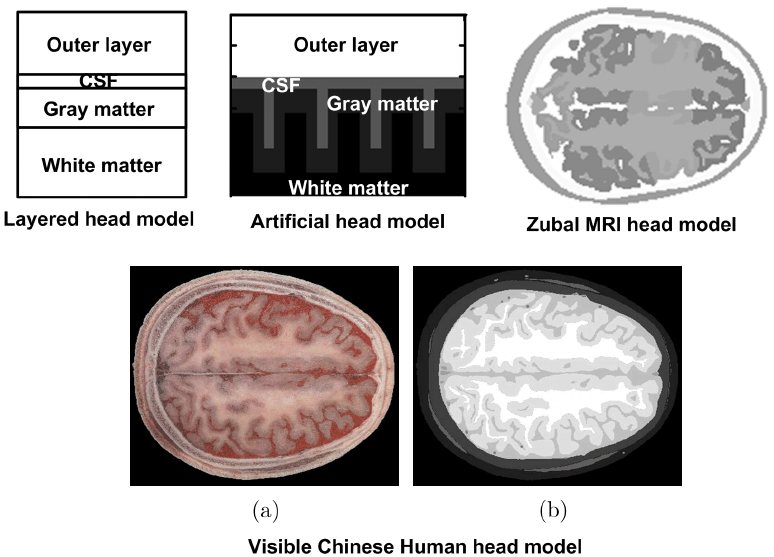
Fig. 1. Head models. VCH head model: (a) Digital color photograph of one head slice in the VCH dataset; (b) Segmentation of the slice in